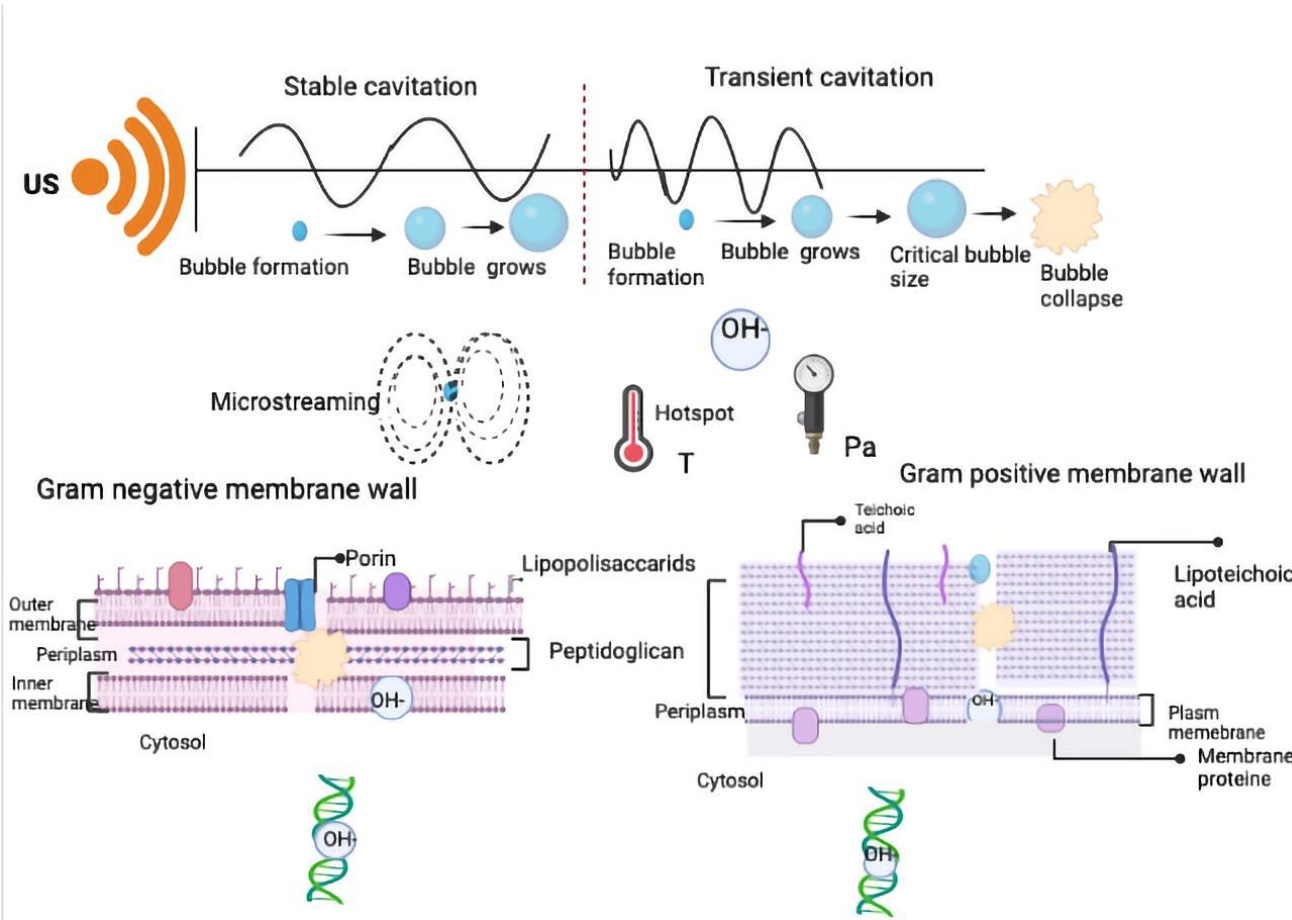
Figure 2. Mechanism of action of ultrasound against bacteria (created with Biorender.com).